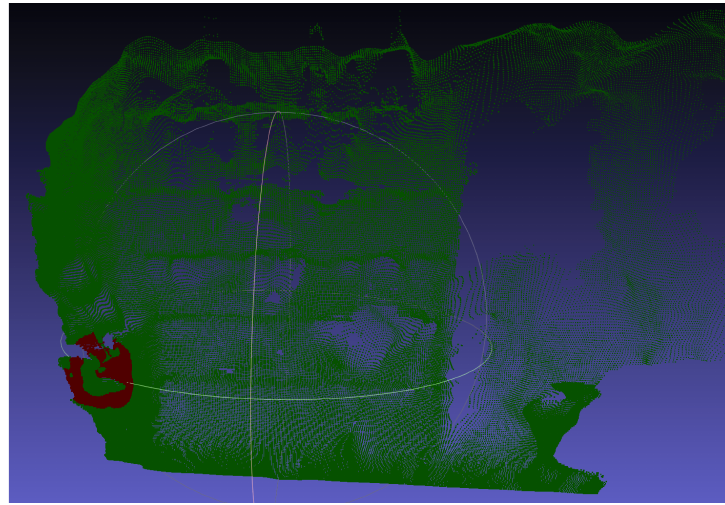
Figure 13. Incorrect detection.